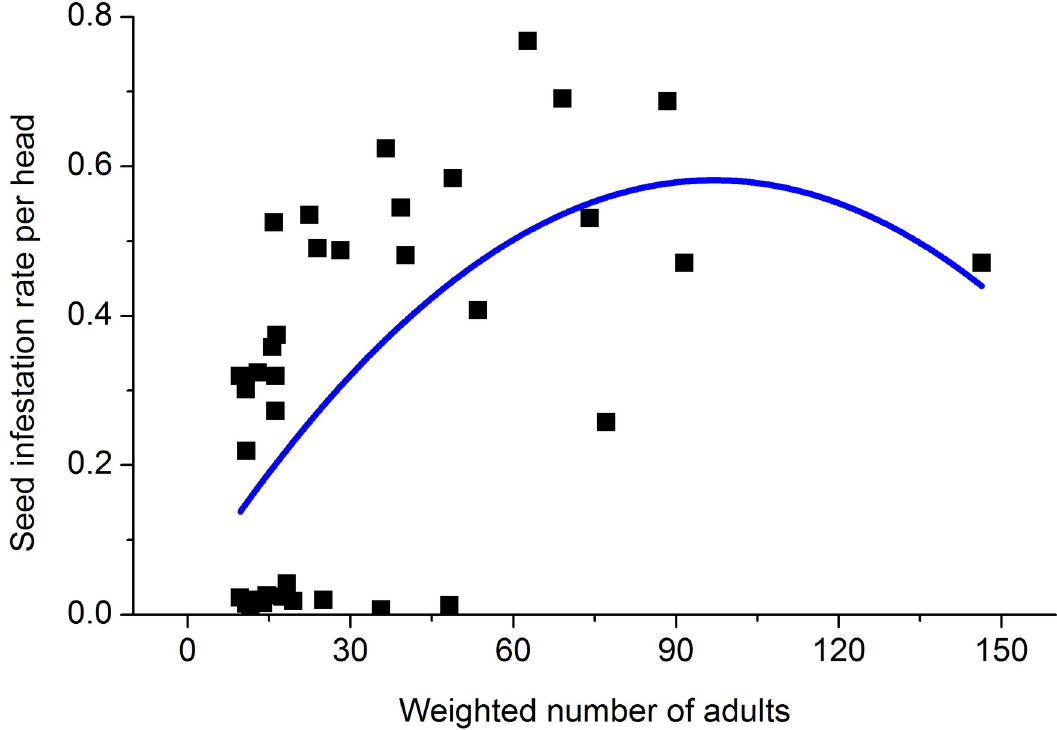
Fig 4. Quadratic regression of seed infestation rate per sunflower head on number of H . nebulellum adults weighted by proportion of daily oviposition to total oviposition. The sample size was